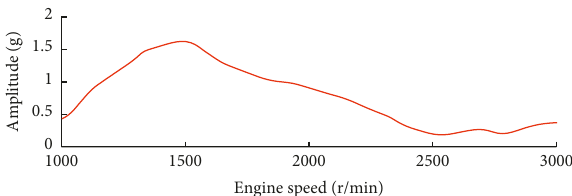
Figure 10: Deflection amplitude changes over different engine